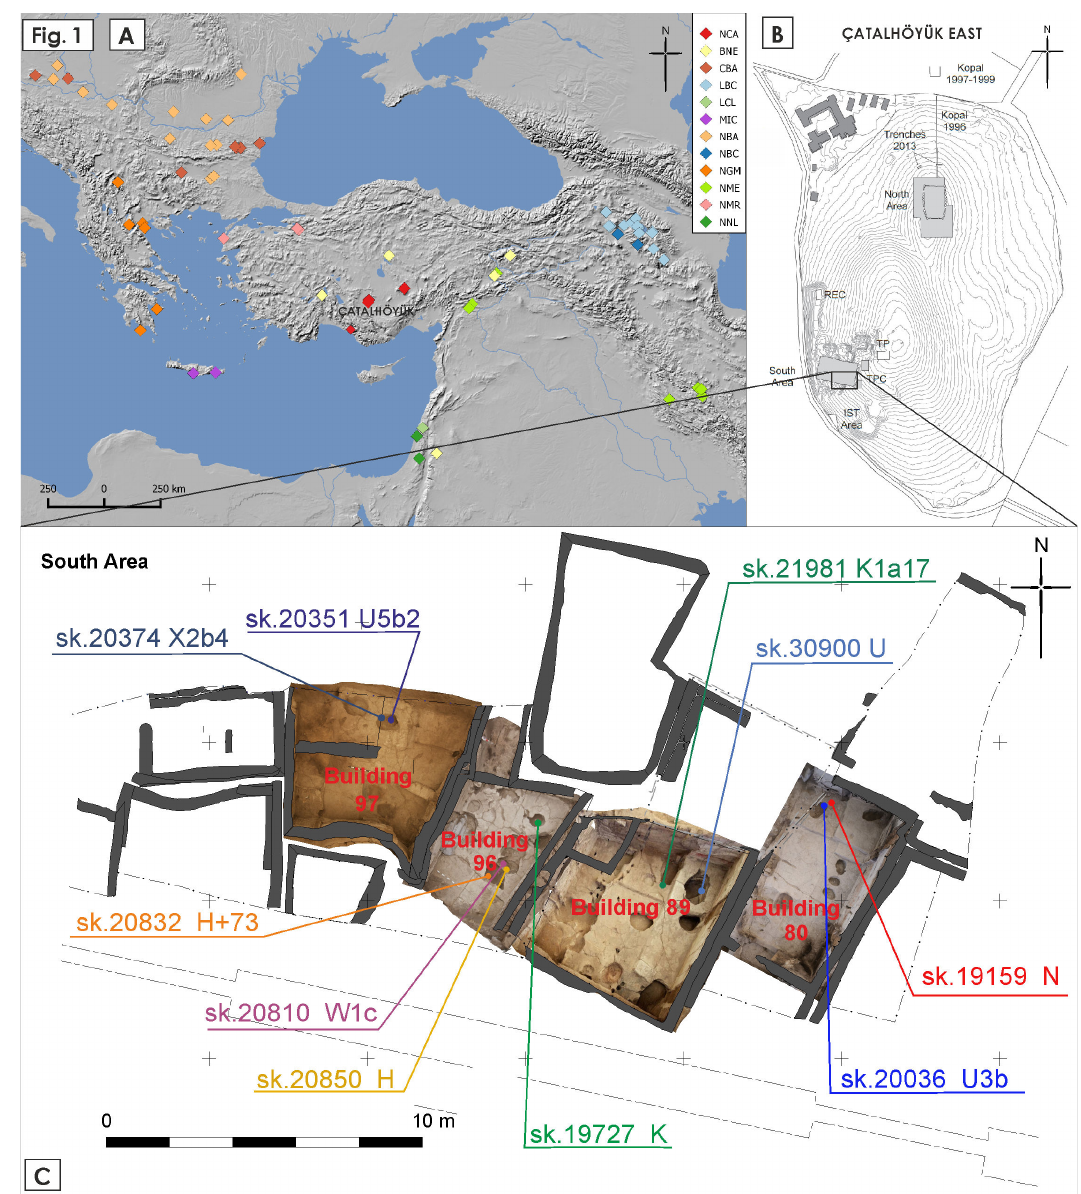
Figure 1. ( A ) The location of Çatalhöyük and other sites with complete mitochondrial genomes used as the reference for the study: (BNE) Bronze Age Near East, (CBA) Chalcolithic Balkans, (LBC) Late Bronze Age Caucasus, (LCL) Late Chalcolithic Levant, (MIC) Minoan Create, (NBA) Neolithic Balkans, (NBC) Neolithic to Bronze Age Caucasus, (NCA) Neolithic Central Anatolia, (NGM) Neolithic Greece and Macedonia, (NME) Neolithic Middle East, (NMR) Neolithic Marmara Region, (NNL) Natufian and Neolithic Levant. ( B ) Outline of the Çatalhöyük East mound with visible excavation areas. ( C ) Close-up of the excavation area and buildings targeted for the study with the locations and the obtained mitochondrial haplogroups of the individuals reported in the